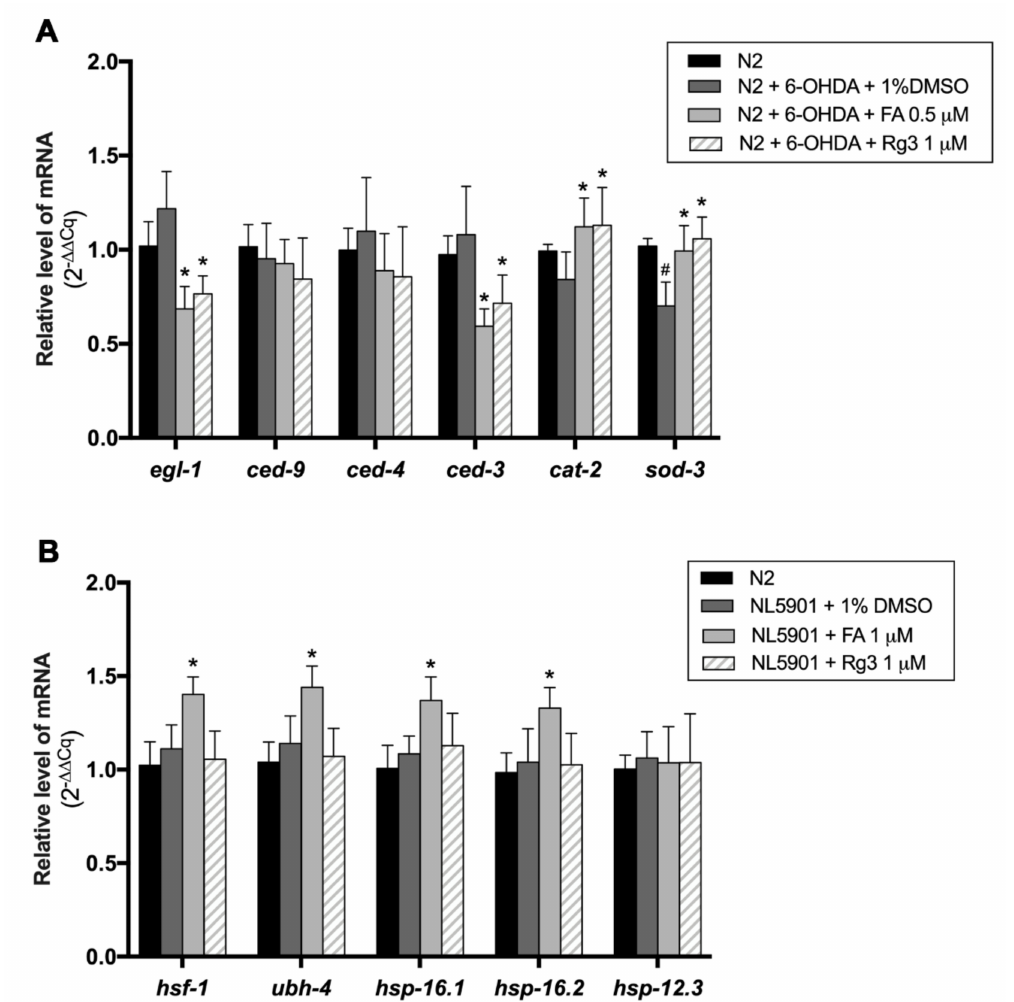
Figure 7. ( A ) Fold change of gene expression levels (2 − ( ∆∆ Cq) ) of apoptosis genes in N2 worms treated with 6-OHDA, 6-OHDA/FA and 6-OHDA/Rg3. ( B ) Fold change of gene expression levels of protein degradation regulator genes in NL5901 worms treated with FA and Rg3. All targeted genes were measured in triplicate, and three independent biological triplicates were performed in each condition. The hash (#) indicates a significant difference between 6-OHDA-induced and uninduced worms ( p < 0.05). The asterisk (*) indicates a significant difference between the control worms and the FA or Rg3-treated worms ( p <